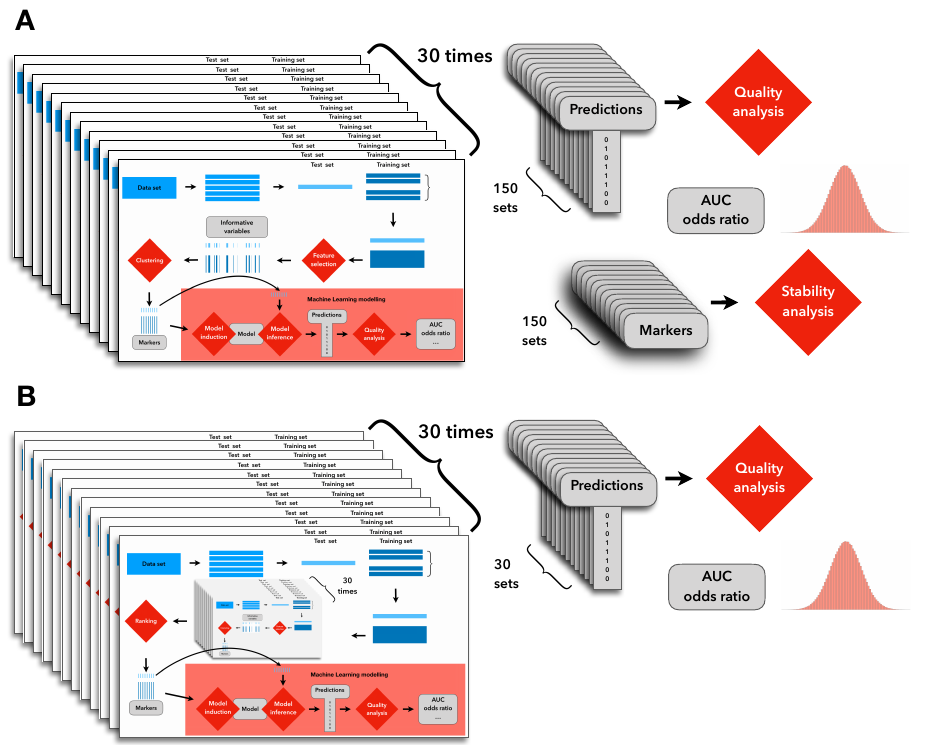
Figure 3. Depiction of the final evaluation. Both variants ( A , B ) from Figure 2 were evaluated, respectively. An external cross validation was used to obtain the mean and standard deviation of quality metrics (AUC, odds ratio). The evaluation of the stability of variant ( A ) (the base protocol) prompted us to create and apply variant ( B ) (the proposed protocol).